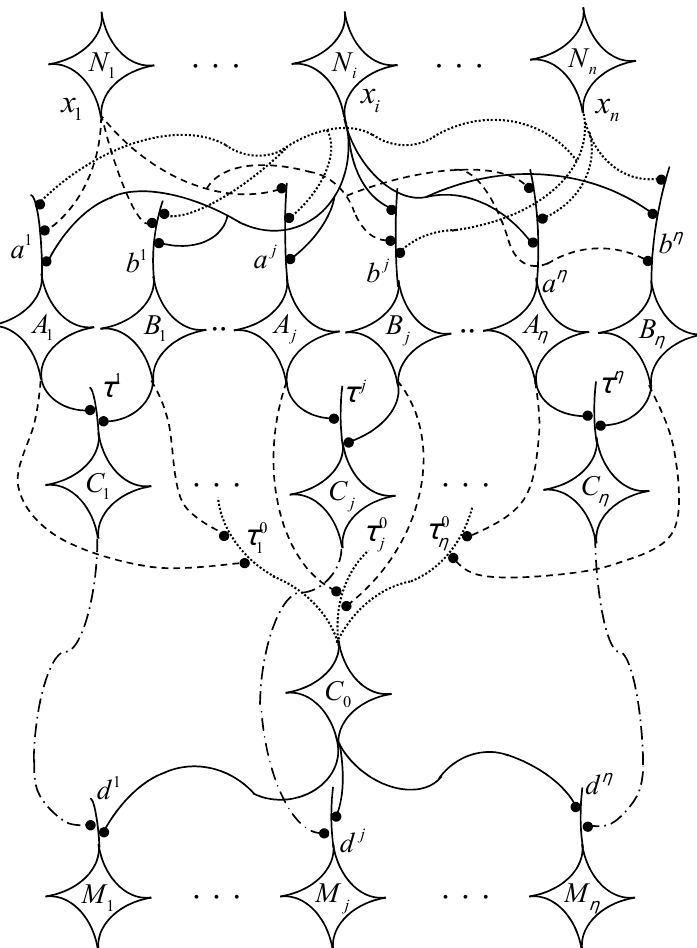
Figure 2. The neural architecture of a LBNN that learns using a similarity measure. Different pathways are shown between the input layer neurons N i and the output neurons M j . The value x i denotes the information transferred from neuron N i to the synaptic sites of neurons A j , B j (first hidden layer) and terminal branches of axonal fibers originating in the AB neurons layer making contact with synaptic sites on dendritic branches of the second hidden layer neurons C j